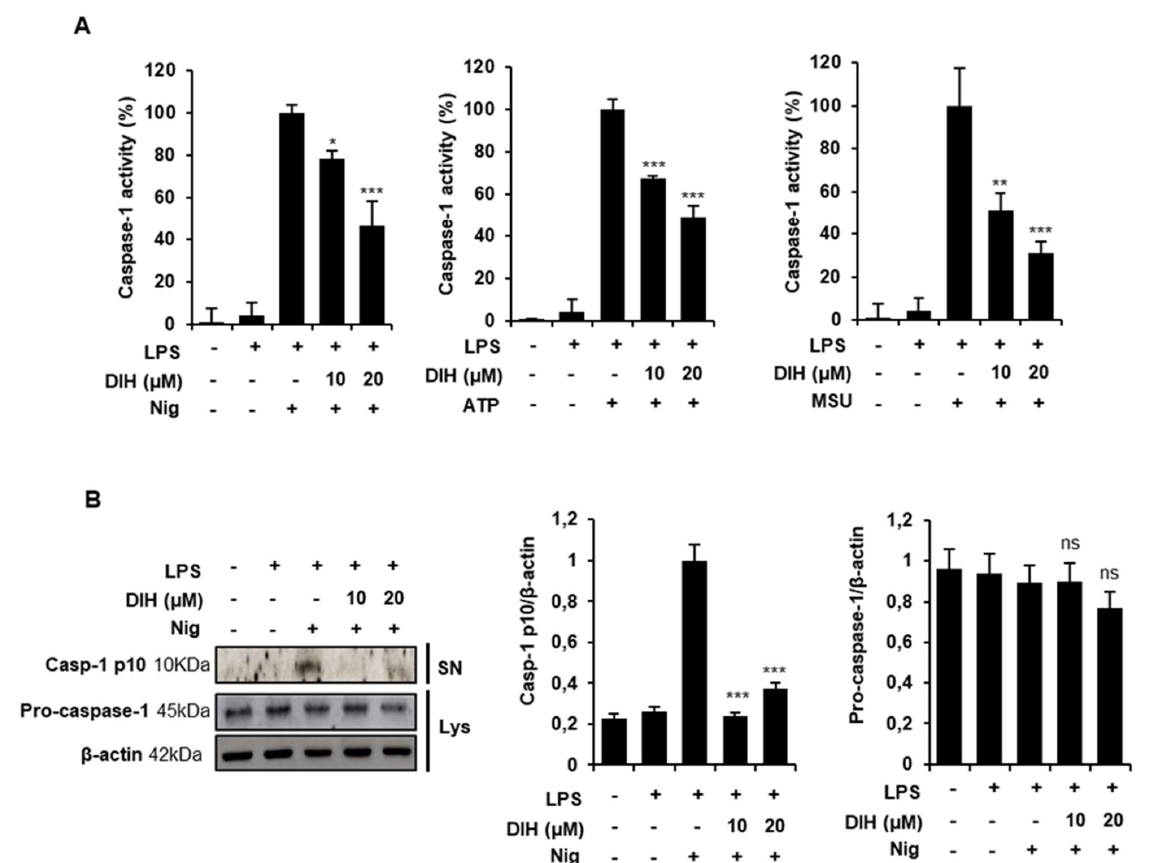
Figure 3. DIH suppresses Caspase-1 activation. ( A ) Caspase-1 activity was determined in LPS-primed J774A.1 cells stimulated with the inflammasome activators: Nig (20 µ M, 1 h), ATP (5 mM, 30 min) or MSU (150 mg/mL, 24 h) in the presence of DIH (10, 20 µ M). Data are expressed as means ± SD of percentage of caspase-1 activity in three independent experiments. ( B ) Cleaved caspase-1 (10 kDa) and pro-caspase-1 (45 kDa) expression were analysed by western blot in supernatants (SN) and cell lysates (Lys) after LPS + Nig stimulation in presence of DIH (10, 20 µ M). β -actin was immunoblotted as a loading control. Densitometry analysis shows the mean ± SD of the western blot